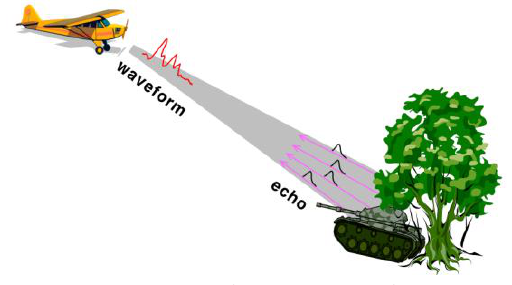
Figure 1. Principle of generating waveform data